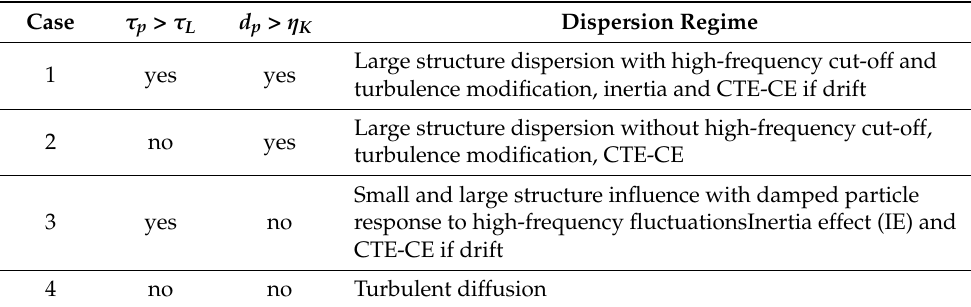
Table 1. Classification of dispersion